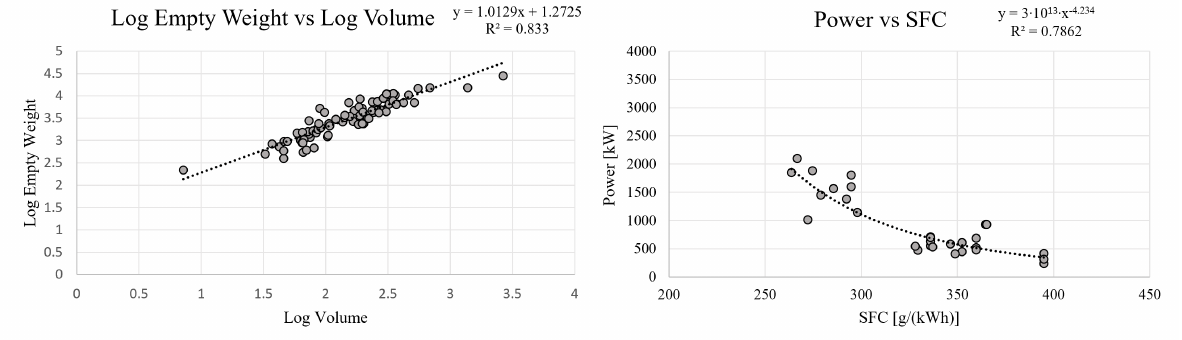
Figure 4. A regression for the relationship between helicopter volume and empty weight on a logarithmic scale ( left ). The relationship between specific fuel consumption (SFC) and power ( right